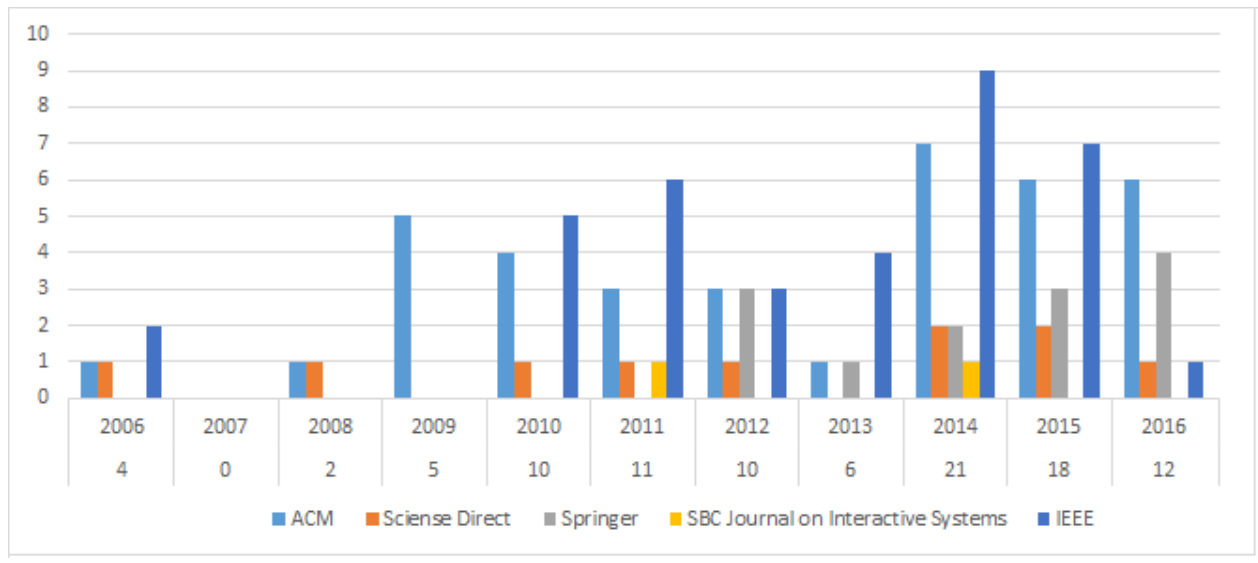
Fig. 1. Publications categorized by year.